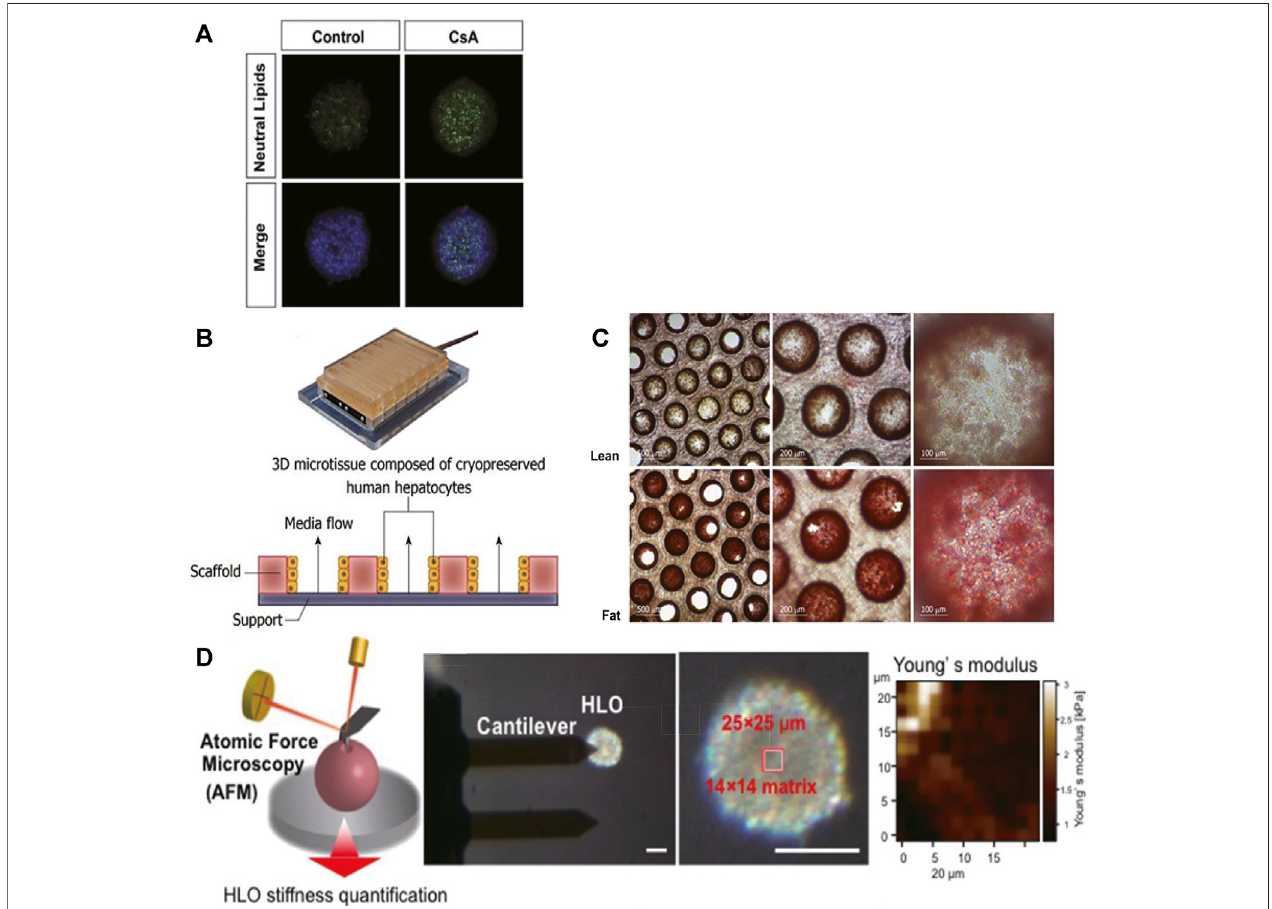
FIGURE 2 | 3D cell culture paradigms support disease modeling of NAFLD. (A) Representative pictures of lipid accumulated in PHH spheroids upon exposure to cyclosporineA(30 μ M)for48 h;scalebars,100 μ m. (B) IllustrationofthePHHliver-on-a-chipmodel. (C) Intracellularfataccumulationintheliver-on-a-chipmodelunder fatcondition(Lower)wasnotedafterOilRedOstaining. (D) SchematicdemonstrationofstiffnessmeasurementbyAFM.Thetopregionofeachsingleorganoid(14 × 14 matrix in a 25 × 25 μ m square) was scanned with an AFM cantilever. Scale bar, 100 μ m. Young ’ s modulus on each scanned spot is shown in the heatmap. (A) Modi fi ed with permission from Bell et al. (2016). (B,C) Modi fi ed with permission from Kostrzewski et al. (2017). (D) Modi fi ed with permission from Ouchi et al.